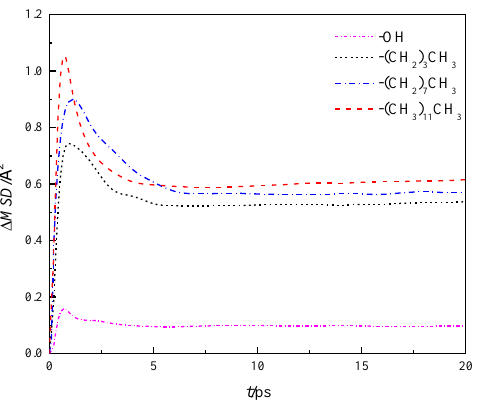
Figure 8. Overall average ∆ MSD of water in nanochannel with different surface characteristics. Table 2. Diffusion coefficient of water in nanochannel with different surface characteristics. Nanochannel Type